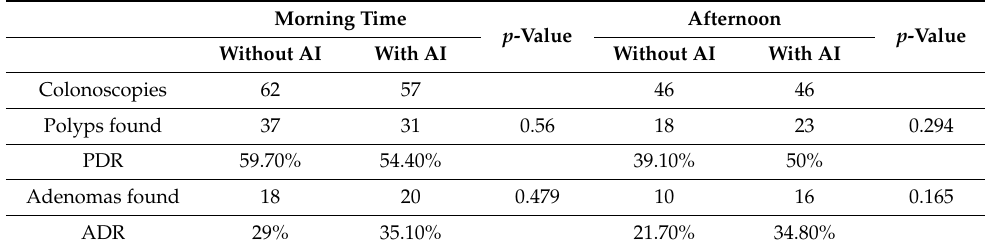
Table 3. The results of DR 2